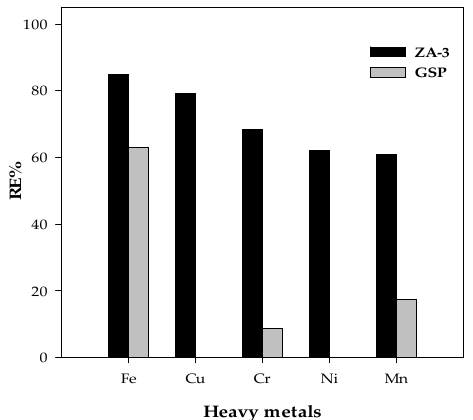
Figure 7. The removal percentages of heavy metals from water at an extremely acidic medium for samples ZA ‐ 3 and GSP.